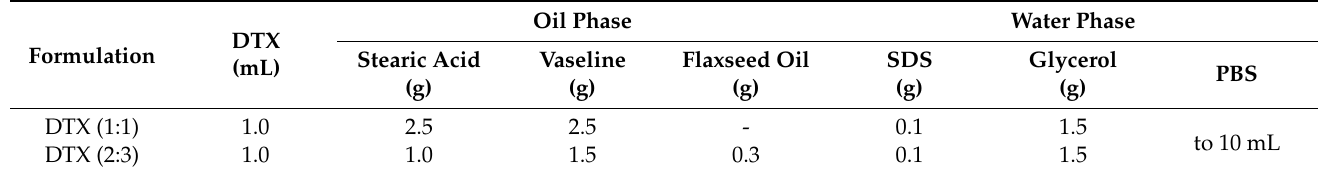
Table 1. Optimization of oil phase composition of DTX-containing emulsion via drug release in vitro.